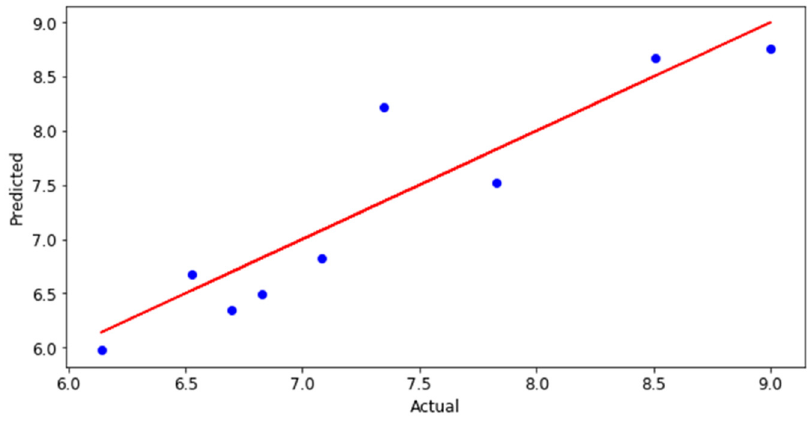
Figure 9. Actual versus predicted outcome using ATI (3 h), % water content, and soil type information from the KNN model.